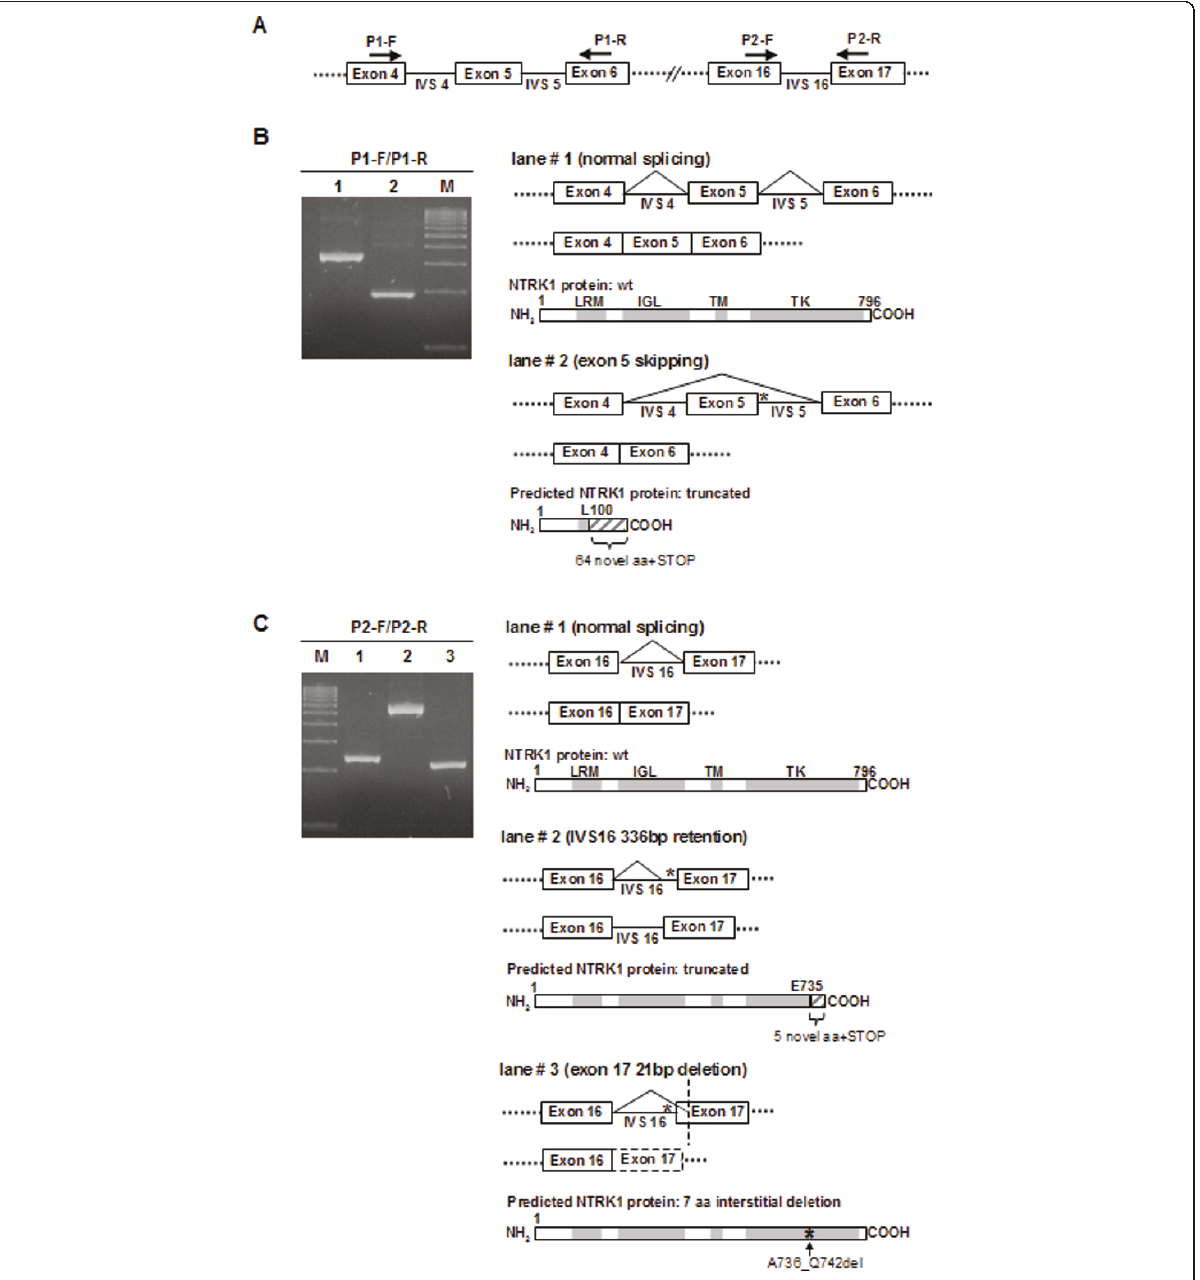
Figure 2 Characterization of the effect of IVS 5 (c.574+1G>C) and IVS16 (c.2206-2A>G) point mutations on NTRK1 splicing . A . Schematic partial representation of NTRK1 exon/IVS structure, indicating the position of the primer sets (P1-F/P1-R and P2-F/P2-R) designed for RT-PCR analysis. B . Left, agarose gel showing the two differently sized amplicons obtained by PCR analysis of cloned P1-F/P1-R RT-PCR products (see “ Methods ” section for details). As illustrated on the right, lane 1 fragment corresponds to normally spliced mRNA, encoding the wild-type (wt) NTRK1 protein, whose structural domains are schematically depicted in the figure (LRM: leucine-rich motif; IGL: immunoglobulin-like; TM: transmembrane; TK: tyrosine kinase). Lane 2 fragment corresponds to an abnormally spliced mRNA lacking exon 5. The encoded NTRK1 protein, depicted below, is predicted to bear a premature stop codon following a novel 64 aminoacid sequence after the L100 residue. C . Left, agarose gel showing the three differently sized amplicons obtained by PCR analysis of cloned P2-F/P2-R RT-PCR products. Lane 1 corresponds to normally spliced mRNA. Lane 2 corresponds to an abnormally spliced mRNA retaining a 336 bp fragment of IVS16. The predicted NTRK1 protein, depicted below, would have a premature stop codon following a novel 5 aminoacid sequence after the E375 residue. Lane 3 corresponds to an abnormally spliced mRNA lacking a 21 bp fragment of exon 17. As indicated, this in frame deletion is predicted to encode an NTRK1 protein bearing a 7 aminoacid interstitial (A736_Q742del) deletion in its TK